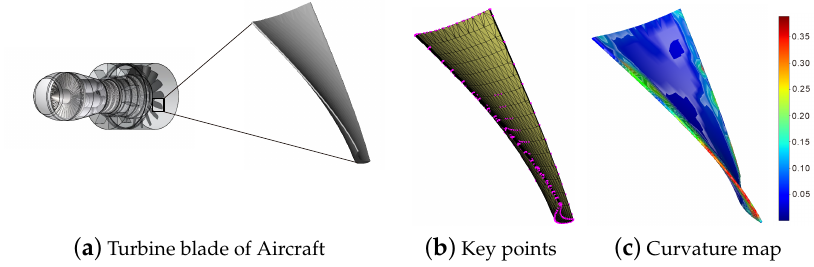
Figure 8. Curvature map of the turbine blade.